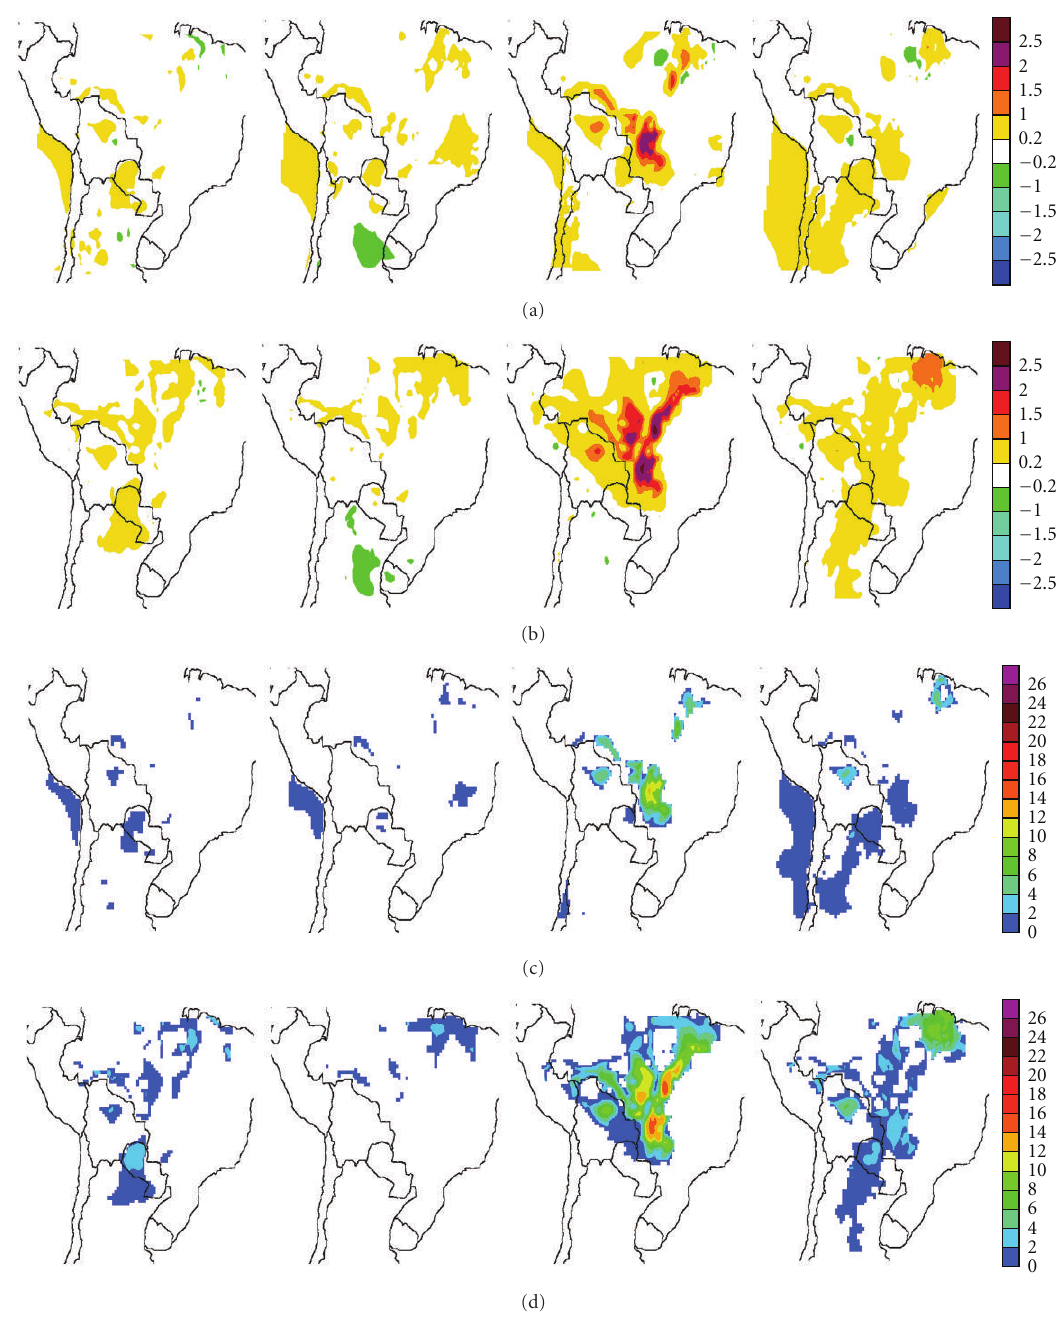
Figure 11: Same as Figure 10 for ERA-40-driven PRECIS